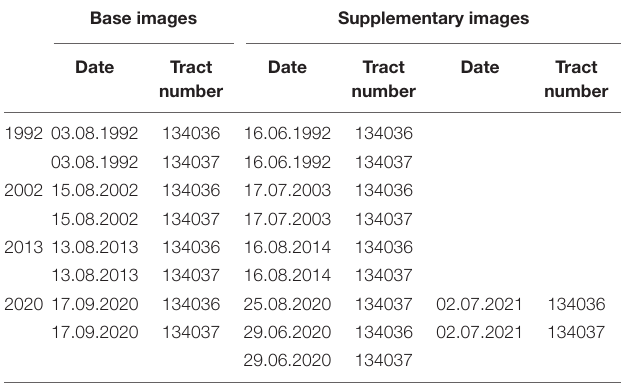
TABLE 1 | Landsat images used in this